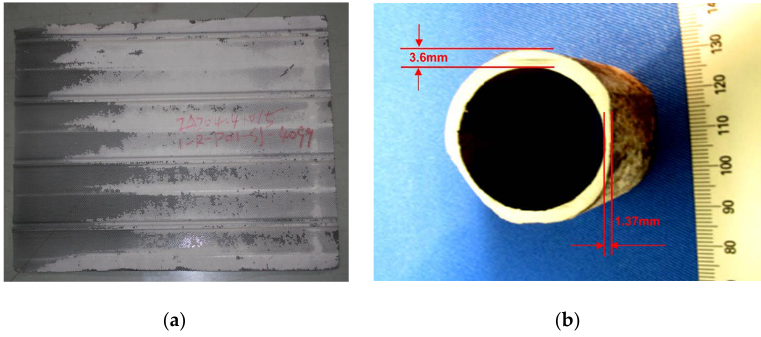
Figure 1. Particle erosion. ( a ) SCR catalyst; ( b ) economizer (reprinted with permission from reference [5]. Copyright 2018 ELSEVIER ).